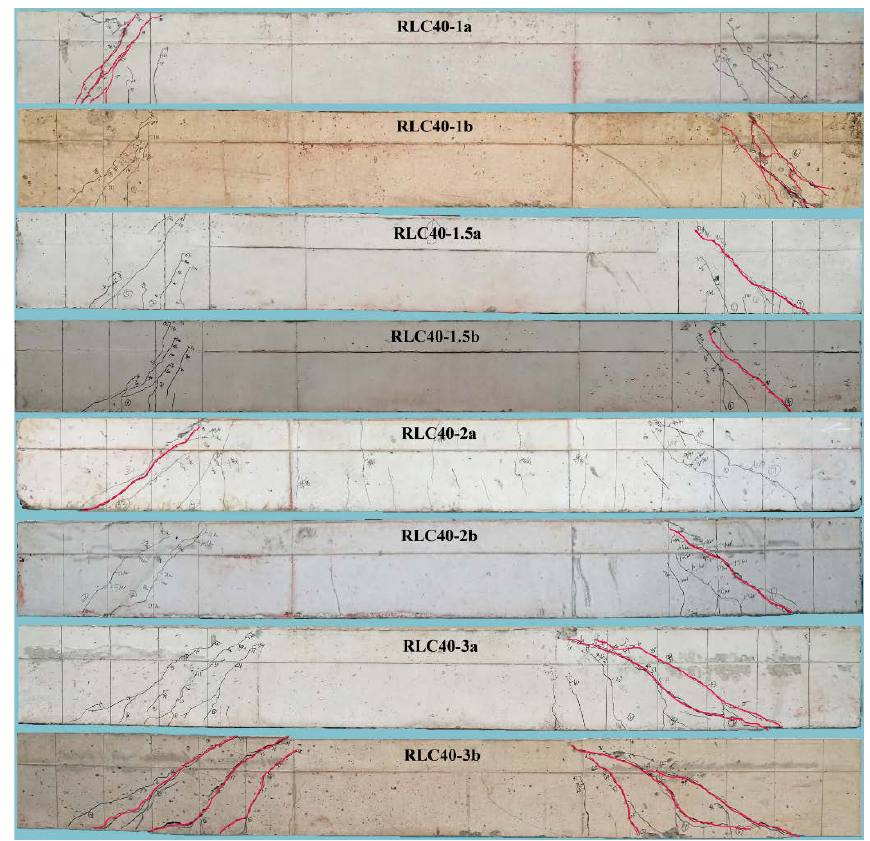
Figure 3. Crack distribution and failure pattern of test beams with different λ.